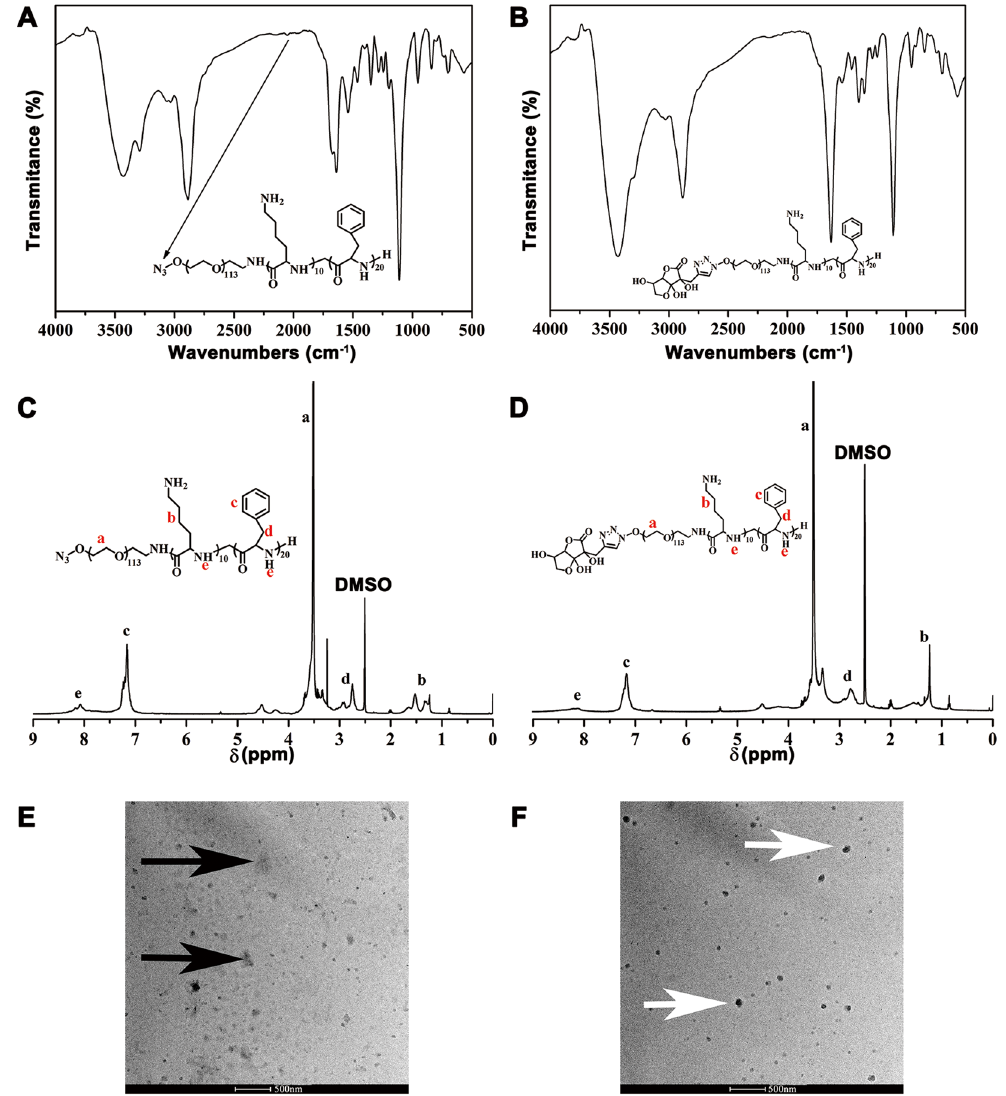
Figure 2. The characterization of the targeted and non-targeted copolymers. The FT-IR spectra of N 3 -PEG- pLys-pPhe ( A ) and DHA-PEG-pLys-pPhe ( B ). 1 H NMR spectrum of N 3 -PEG-pLys-pPhe ( C ) and DHA-PEG- pLys-pPhe ( D ), in which the letters a–e correspond to the protons in the structural formula. TEM image of N 3 - PEG-pLys-pPhe ( E , black arrows) and DHA-PEG-pLys-pPhe ( F , white arrows).